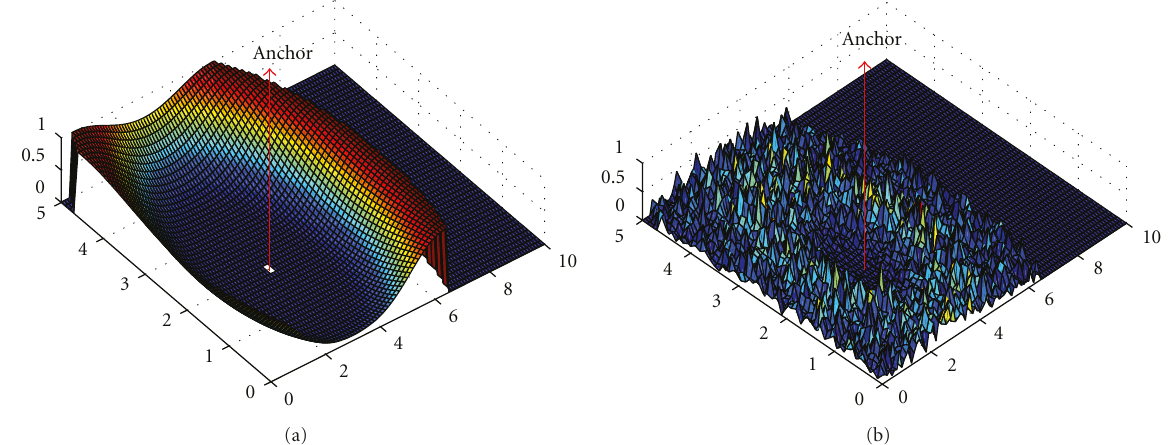
Figure 9: Pairwise potential function ψ ut ( x ∗